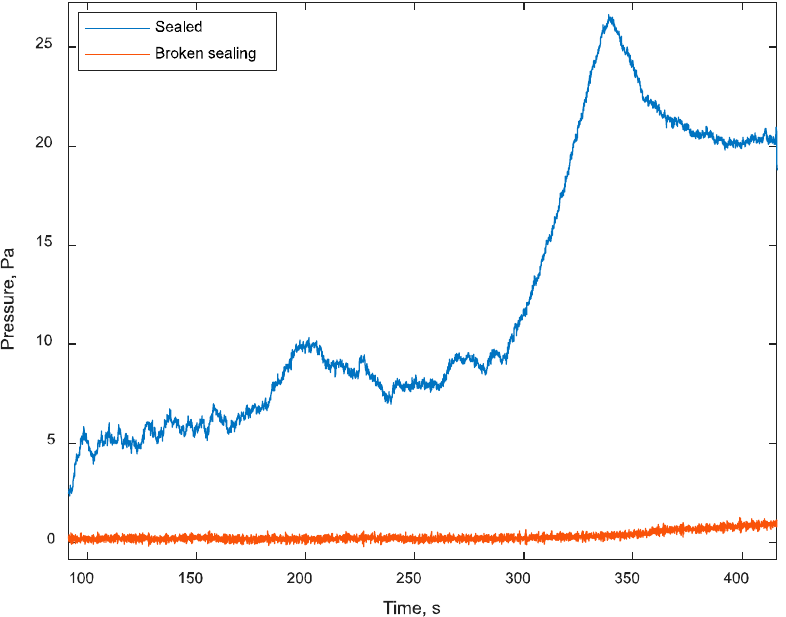
Figure 9. Comparison between the pressure signals at the sealed and non-sealed oven during heating.